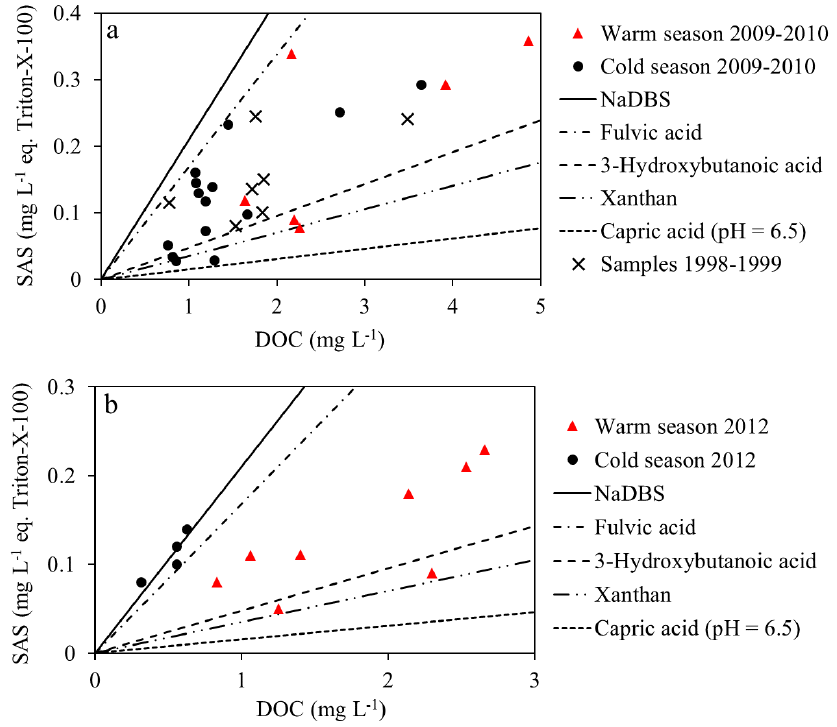
Figure 5. Correlation concentrations of SAS vs. DOC values obtained in the cold / warm season in daily rain samples in Zagreb: ( a ) bulk samples from 2009 / 2010 (current study) ( b ) wet—only samples from 2012 [68] The lines correspond to the model substances [65] .